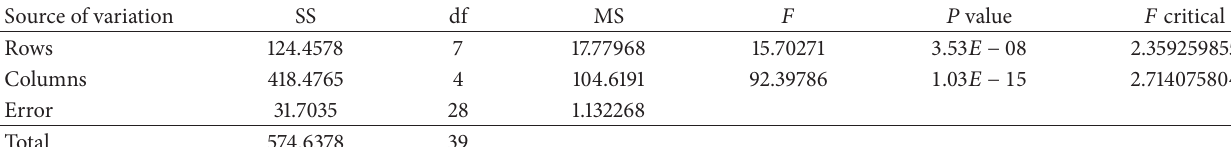
Table 11: VFA test results (ANOVA: two-factor without